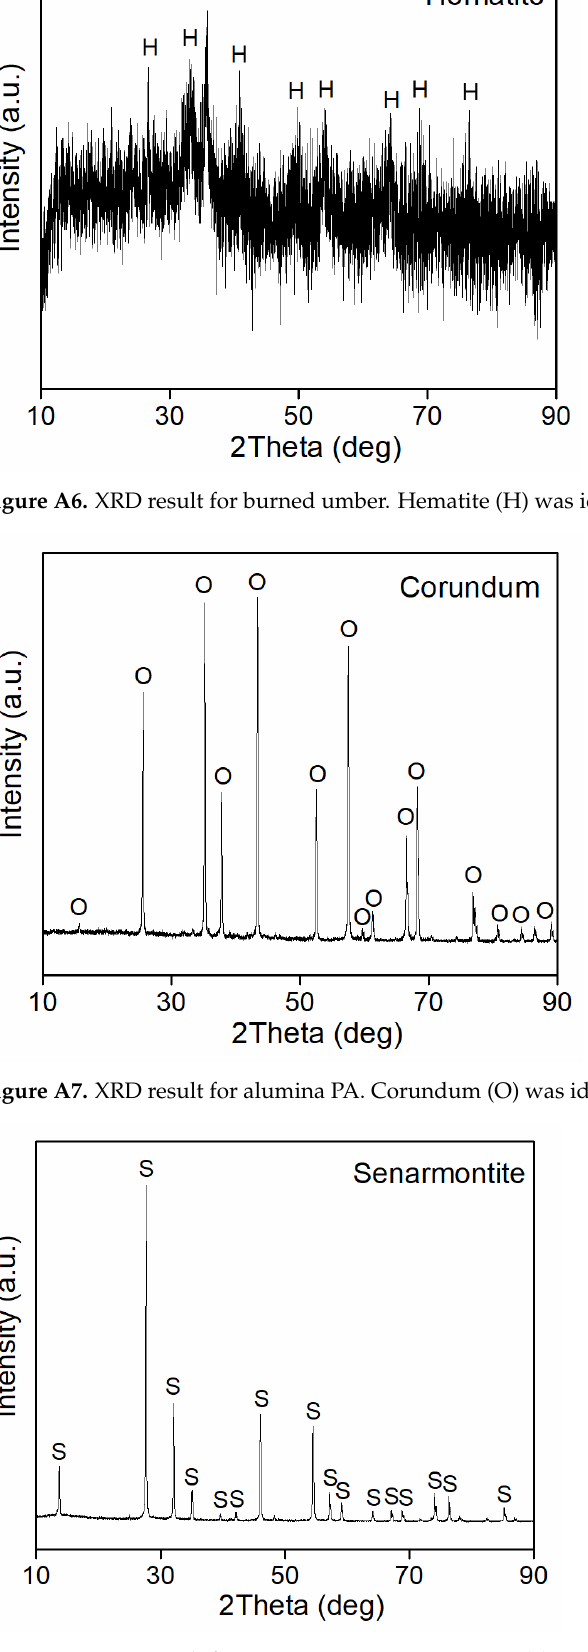
Figure A8. XRD result for antimony PA. Senarmontite (S) was identified.